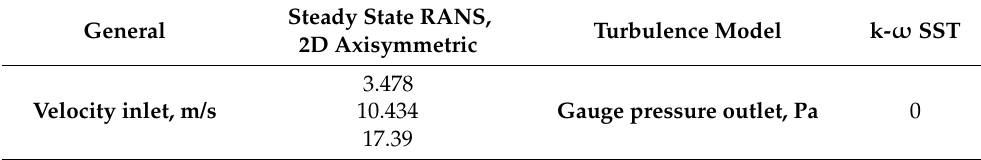
Table 3. Mesh and solver